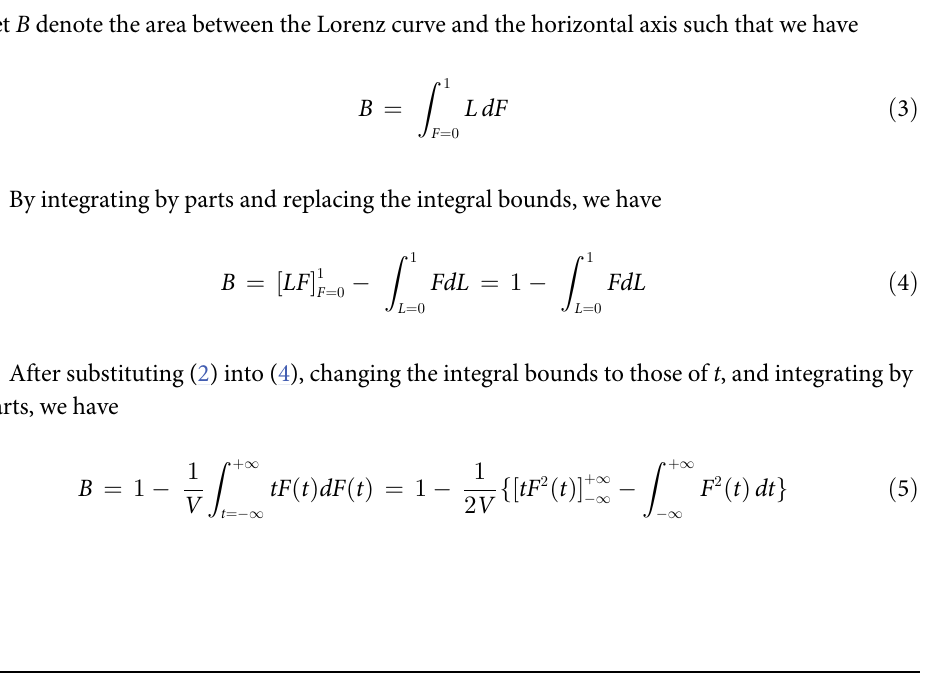
Fig 1. Lorenz curve and the Gini index. The value of the Gini index equals the area of the shaded gray region.